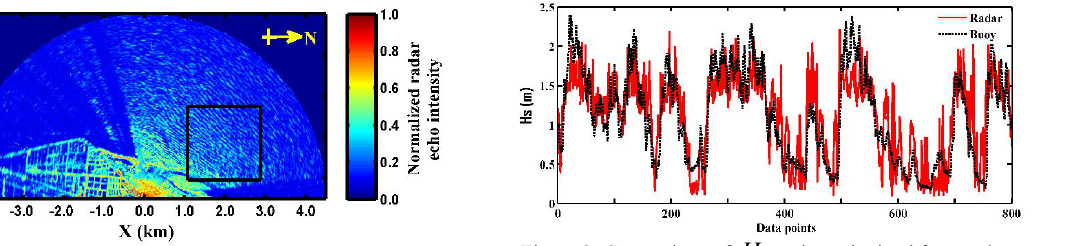
Figure 1. Example of radar image of sea surface. The square in the image delineates the analyzed area